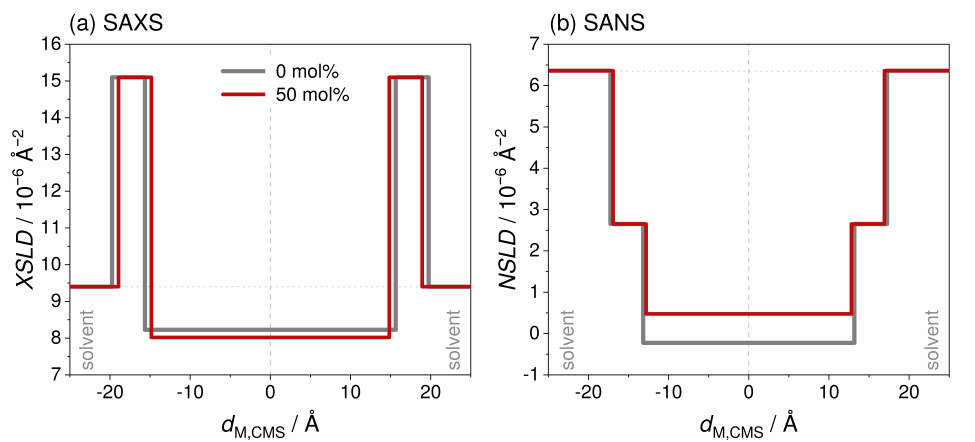
Figure 9. Scattering length density ( SLD ) profiles obtained from ( a ) SAXS and ( b ) SANS for DOPG SUVs without and with 50 mol% glycyrrhizin. The XSLD profiles were derived from fitting the SAXS data of samples prepared in D 2 O with the CMS model. NSLD values for the hydrophobic membrane part were calculated from the respective XSLD values taking the molecular formula of a mixture of the DOPG tail part and the respective glycyrrhizin amount into